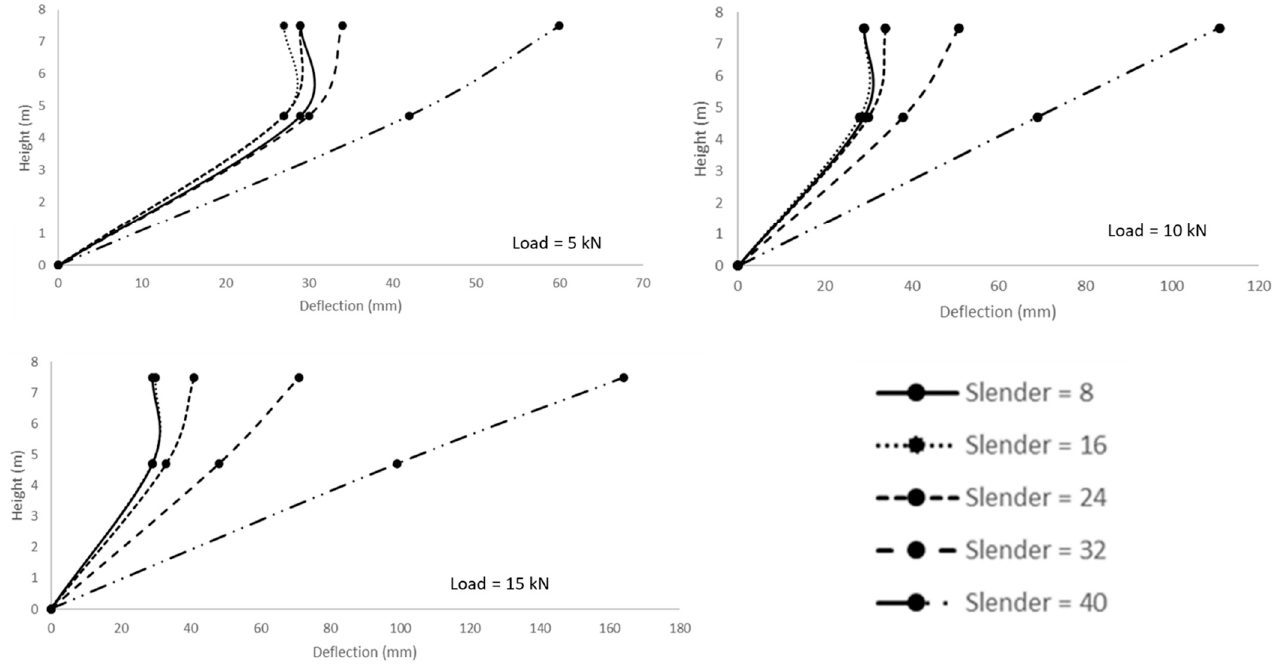
Figure 4. Behavior variation of the slender versus tree height (m) for the scenario 2 (tree height 7.5 m; taper 0.030) and for the simulated horizontal forces (5 kN, 10 kN and 15 kN).